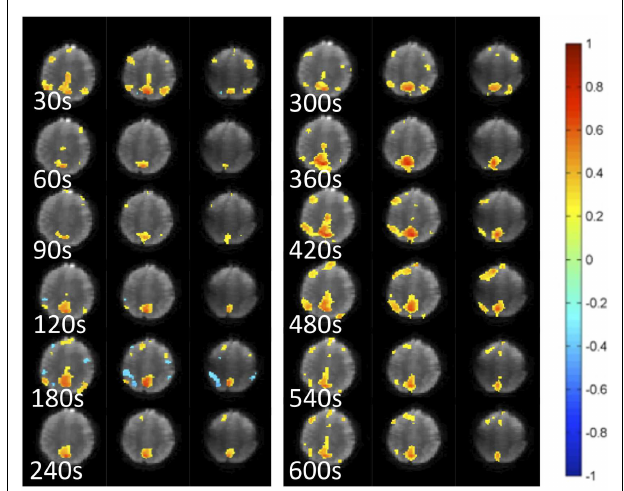
FIGURE 5 | Dynamic changes in temporal correlation within the default mode RSN measured at 30s intervals using MEVI2 (TR: 136ms) and sliding-window seed-based correlation analysis with 30s window in a healthy control .